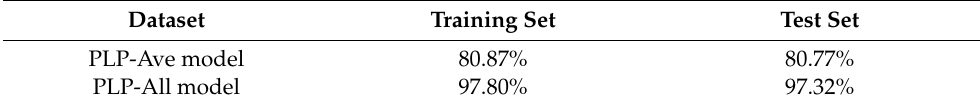
Table 1. Accuracy of PLP-Ave model and PLP-All model.